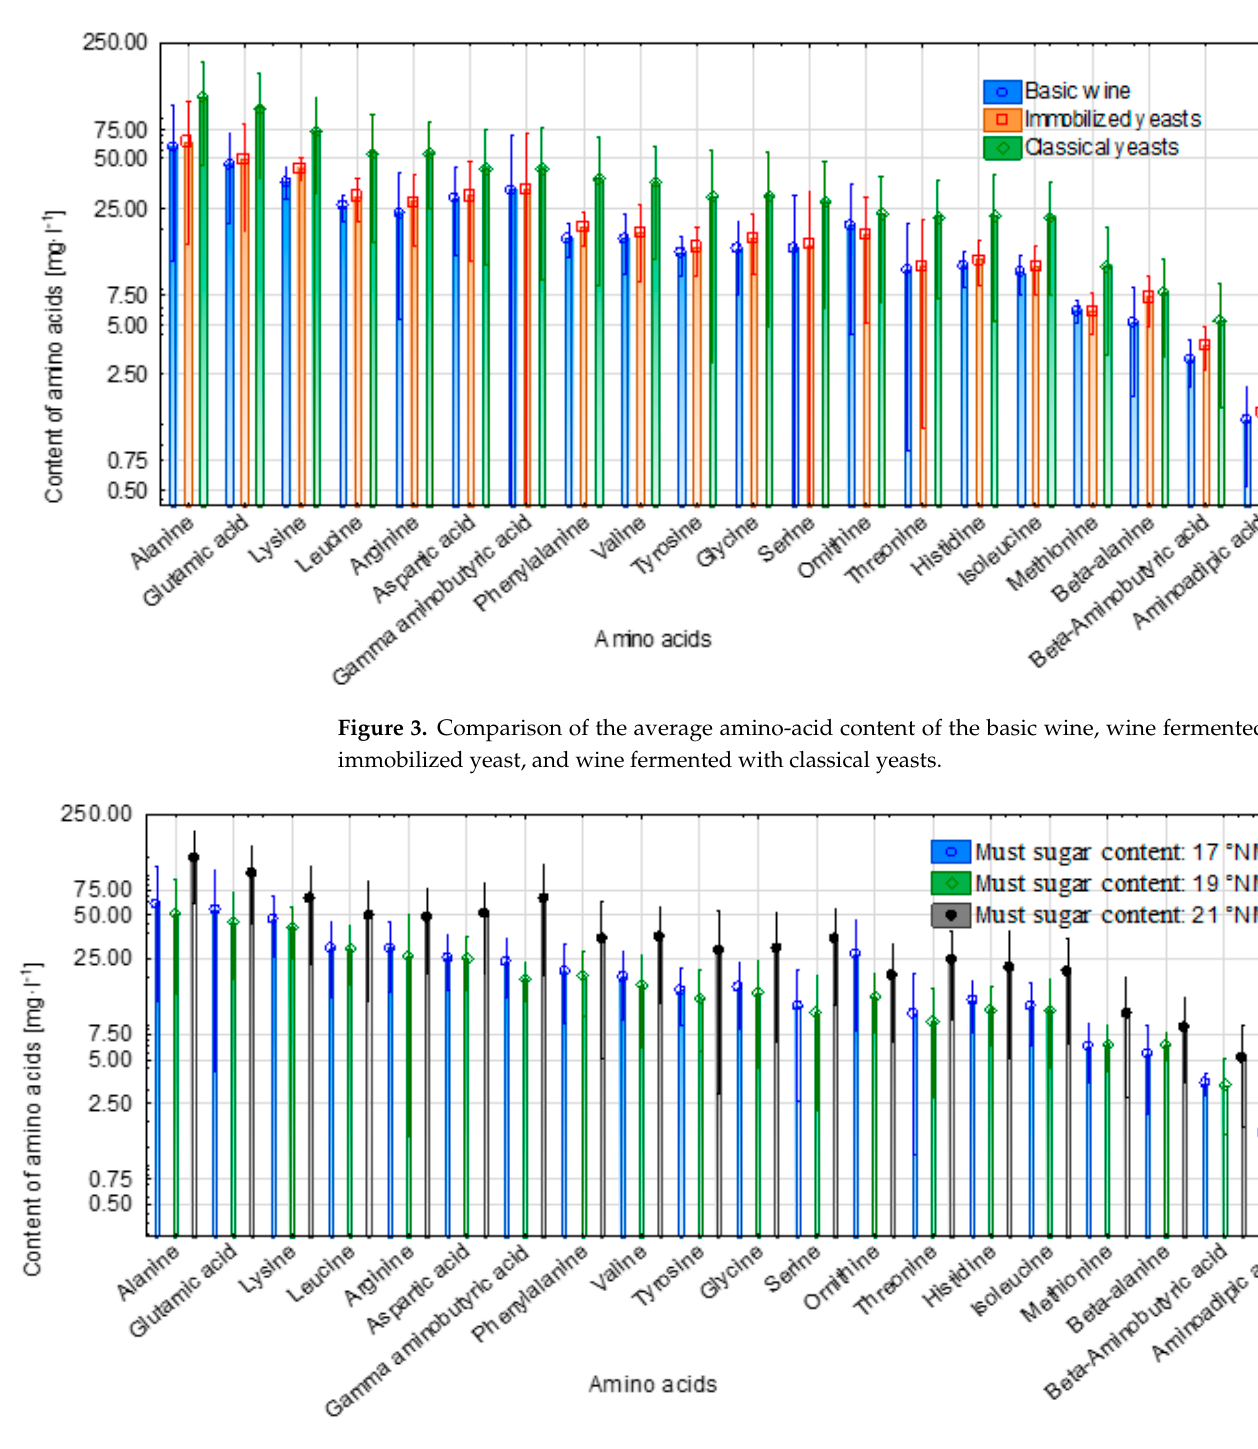
Figure 5. Comparison of average amino-acid content by year.